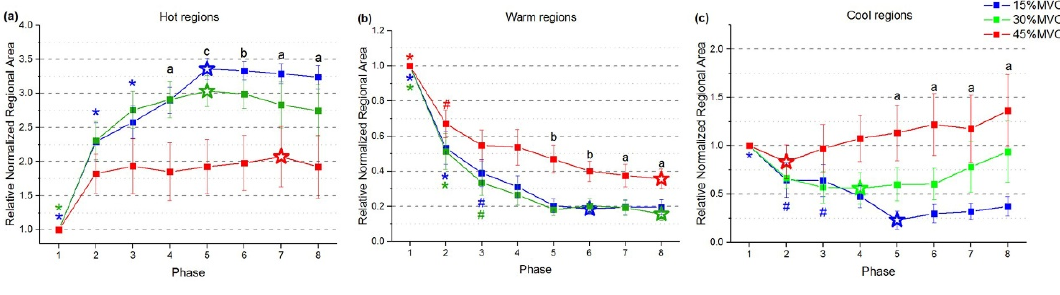
Figure 6. The relative normalized regional area of hot regions ( a ), warm regions ( b ), and cool regions ( c ) during sustain constant index finger contractions at three force levels. ‘ ☆ ’ represent the extreme values. Asterisk and octothorpe indicate significant difference compared with the extreme values (* p < 0.005; # p < 0.05). Different lowercase letters indicate significant effect among force levels (a 0.01 < p < 0.05; b 0.005<p < 0.01; c p < 0.005).